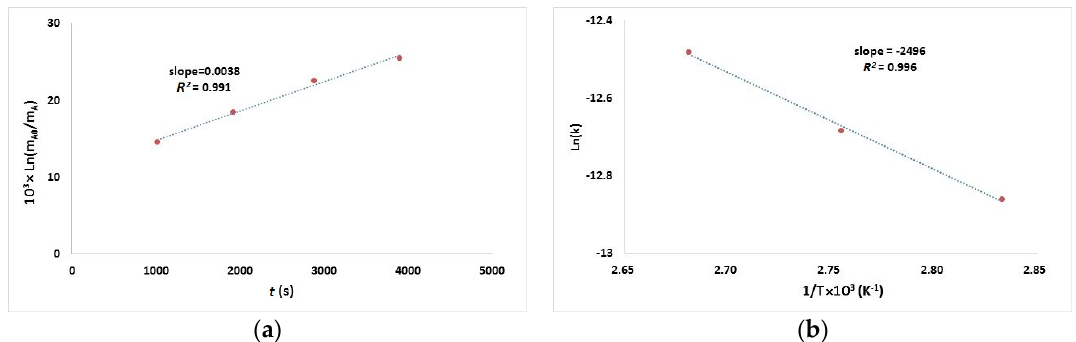
Figure 2. ( a ) The plot of Ln( m A0 / m A ) against time t at 100 °C; and ( b ) the relationship between the reaction rate constant and temperature.